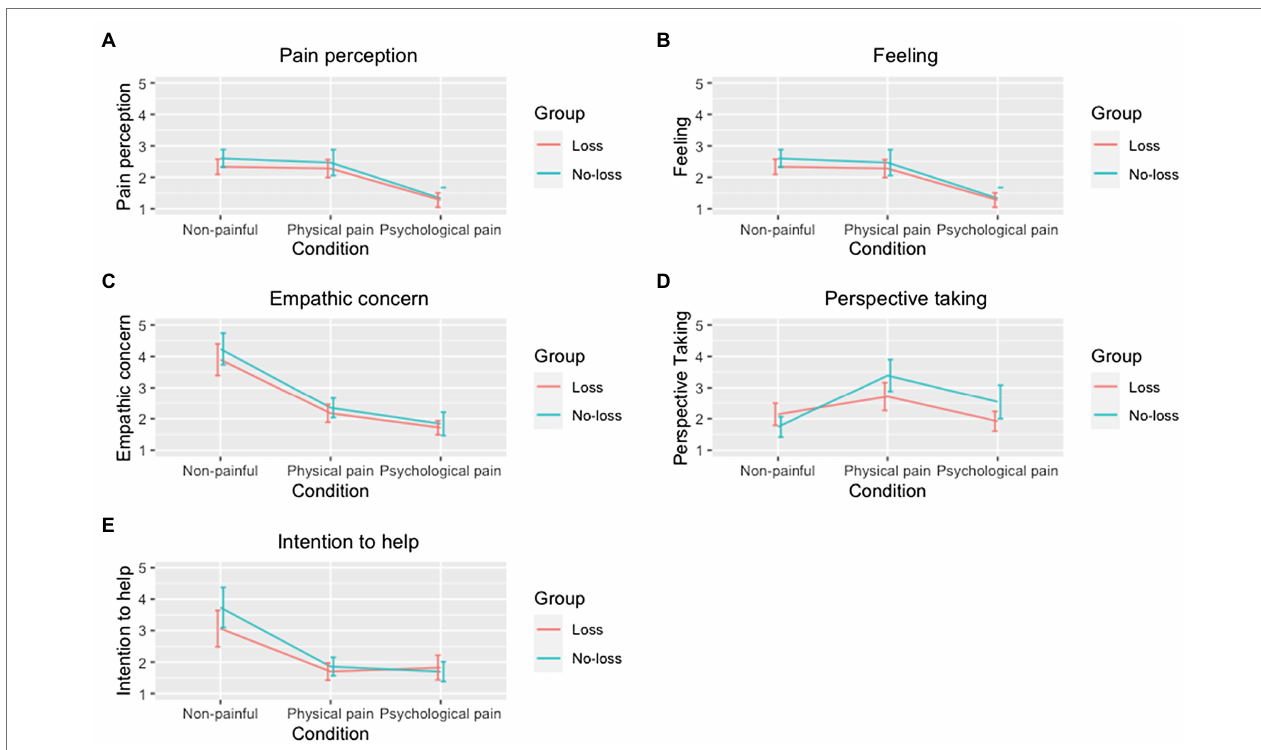
FIGURE 3 | Group comparison based on conditions. (A) Pain perception. (B) Intensity of feeling. (C) Empathic concern. (D) Perspective taking. (E) Intention to help. Each line plot compares the responses per condition and group within each variable. In the Y-axis, 1 means the strongest response (e.g., the greatest pain judgment), while 5 means the weakest response (e.g., the weakest pain